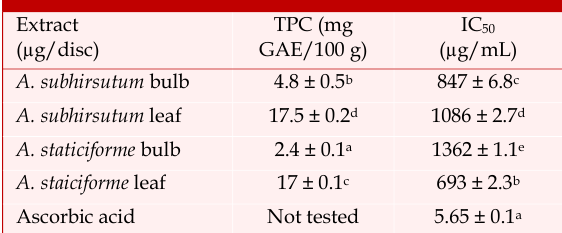
Total phenolic contents and IC 50 values of A. stat- iciforme and A. subhirsutum methanolic extracts Extract TPC (mg (µg/disc) GAE/100 g)